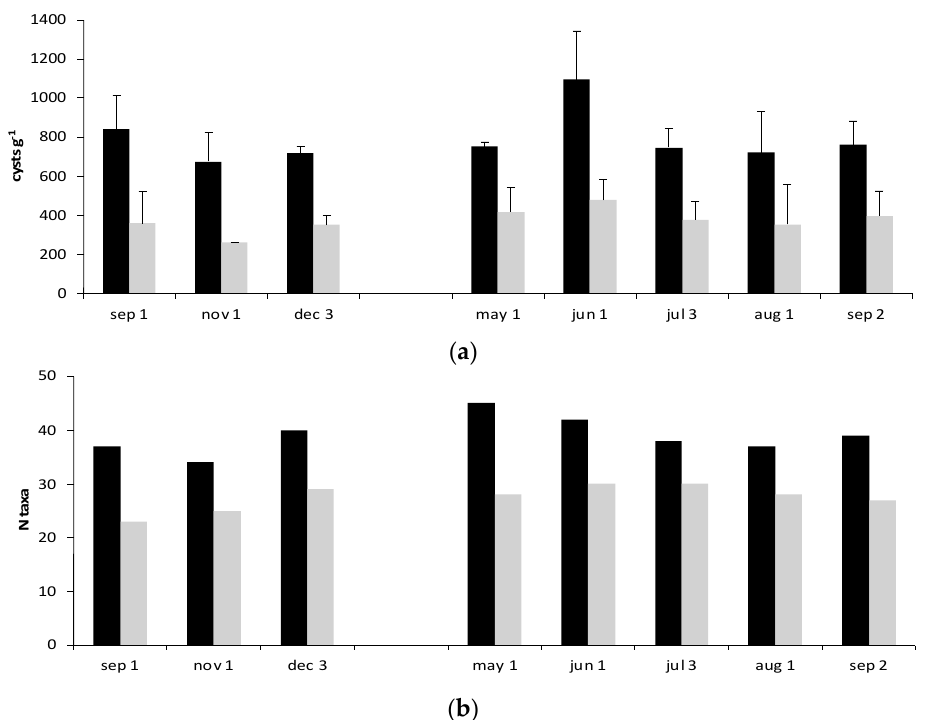
Figure 8. Temporal variation (abundance and taxa richness) of resting stages in surface sediments of the Mar Piccolo, Taranto. ( a ) Total abundance referred to 1 g of dry sediment (average ± SD); ( b ) taxa richness. Black bars, full cysts; grey bars, empty cysts.